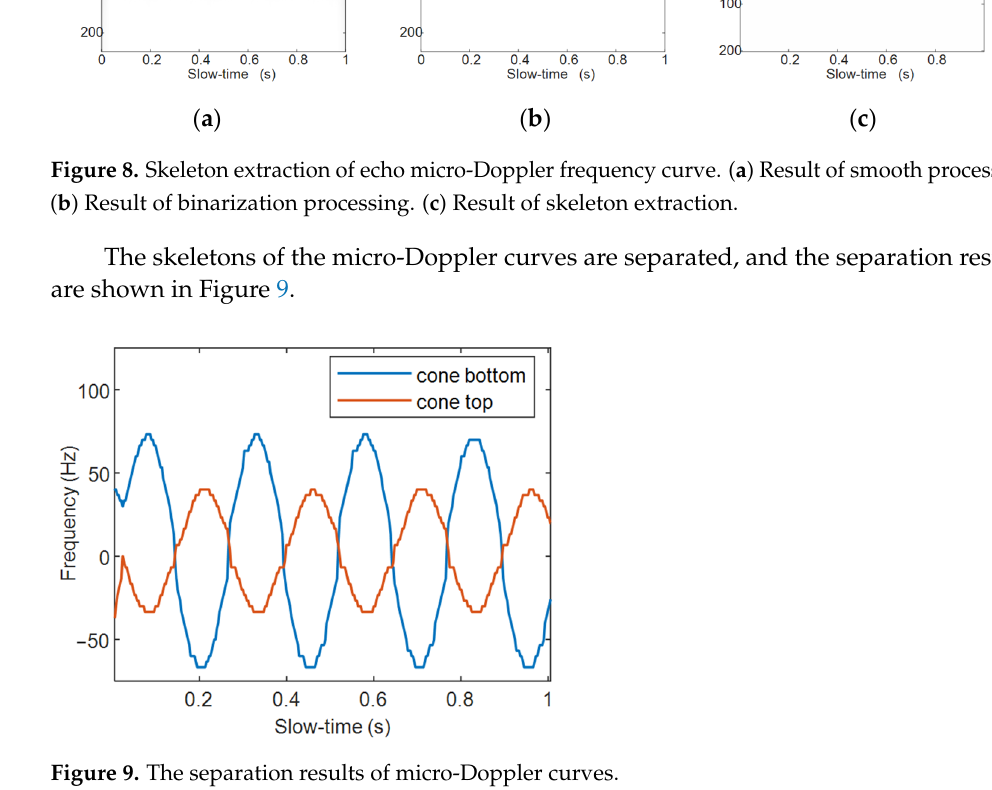
Figure 9. The separation results of micro-Doppler